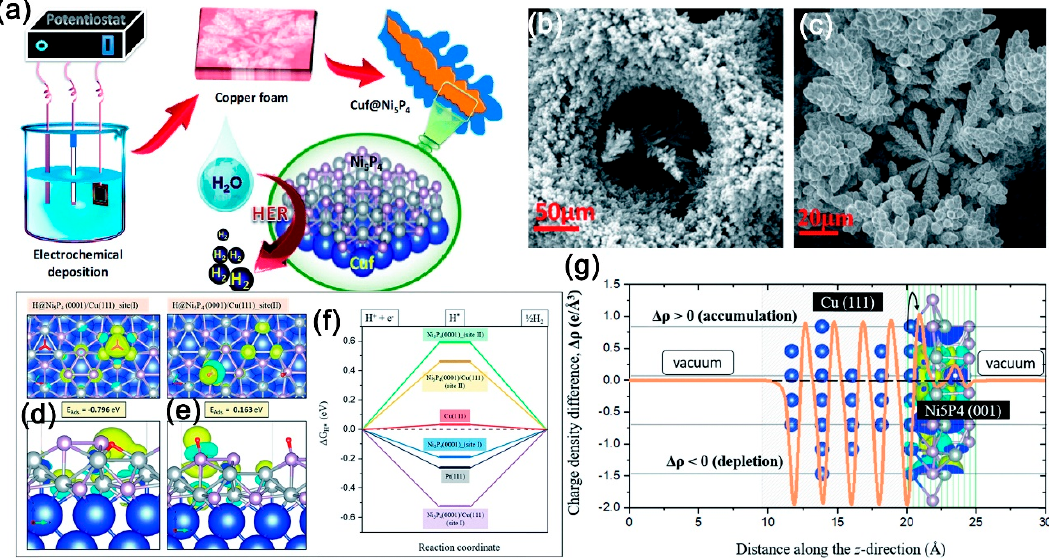
Figure 14. Schematic illustration of the electrochemical synthesis of nickel phosphides on Cu foam ( a ), SEM images of the Ni 5 P 4 on Cu foam ( b , c ), top and side view of H* adsorption over the three-fold Ni site of the Ni 5 P 4 (0001)/Cu (111) (site I) ( d ), and H* over the on-top P site of the Ni 5 P 4 (0001)/Cu (111) surface (site II) ( e ). The differential ground state charge density distribution around the adsorbate (H*) is at an iso-level of 0.59 × 10 − 2 eÅ − 3 . The Δ G H* of the reaction intermediate (H*) on different metal-catalyst surfaces ( f ) and charge density difference and charge transfer at the interface between Cu (111) and Ni 5 P 4 (001) surface ( g ). Reproduced with permission from Reference [142], Copyright The Royal Society of Chemistry, 2019.